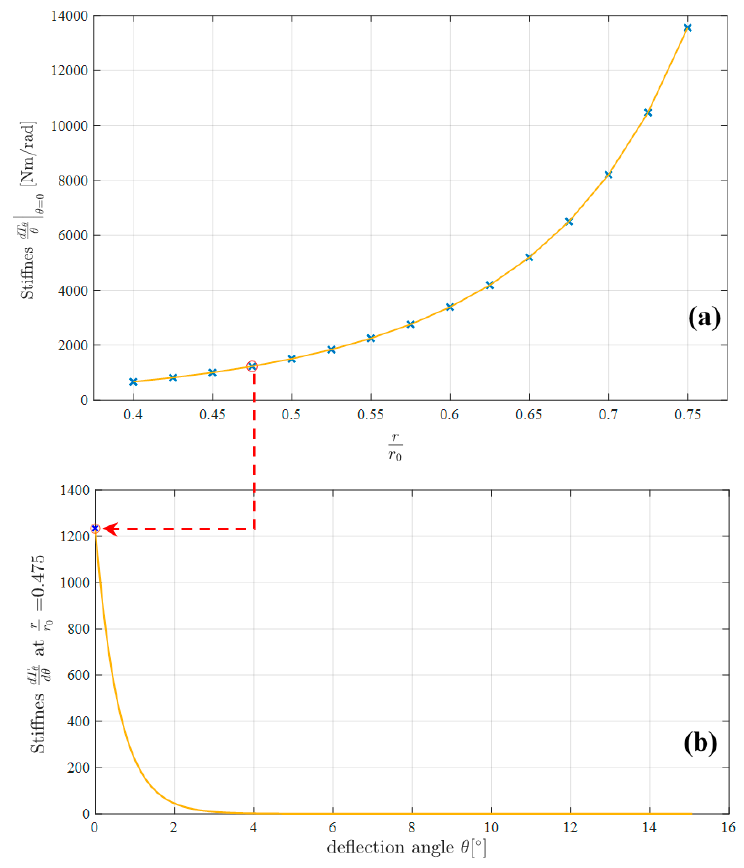
= r 0 (cid:3045) = (cid:3045) (cid:3116)